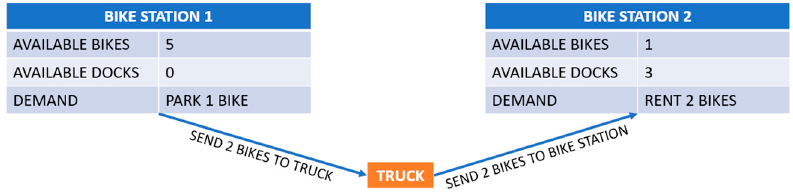
Figure 2. Rebalancing activity example.